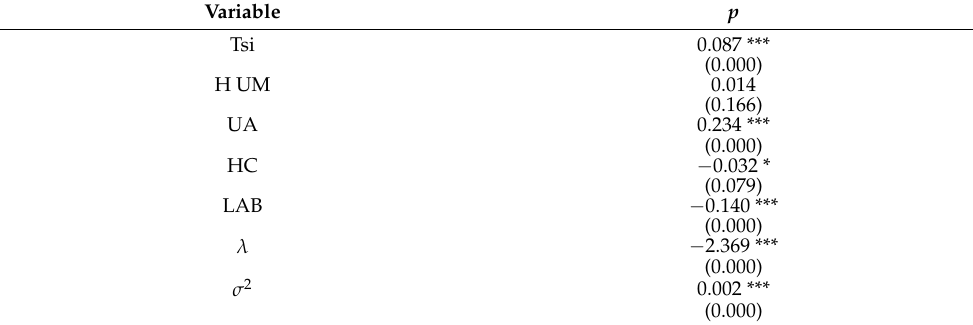
Table 7. Space panel regression